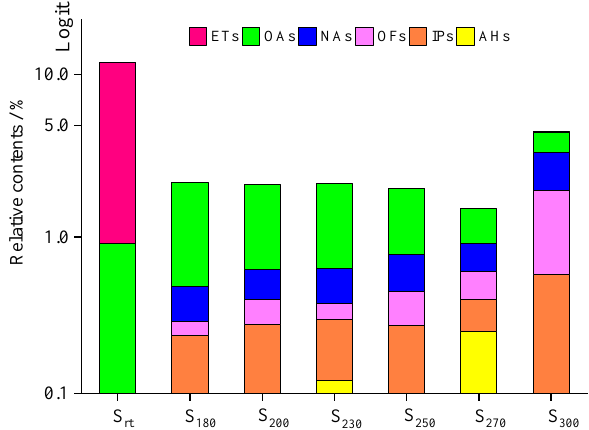
Figure 6. Distribution of group components in S rt and S 180 – S 300 .